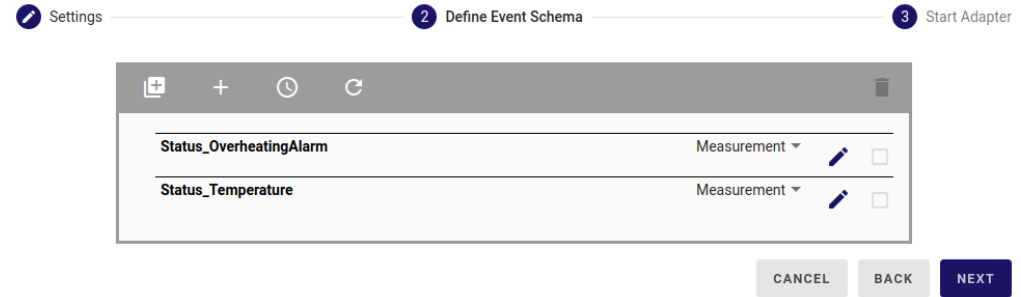
Figure 7. Dialog to modify the event schema of a DT Source showing all properties of an AAS-based DT according to the example AAS shown in Figure 3.